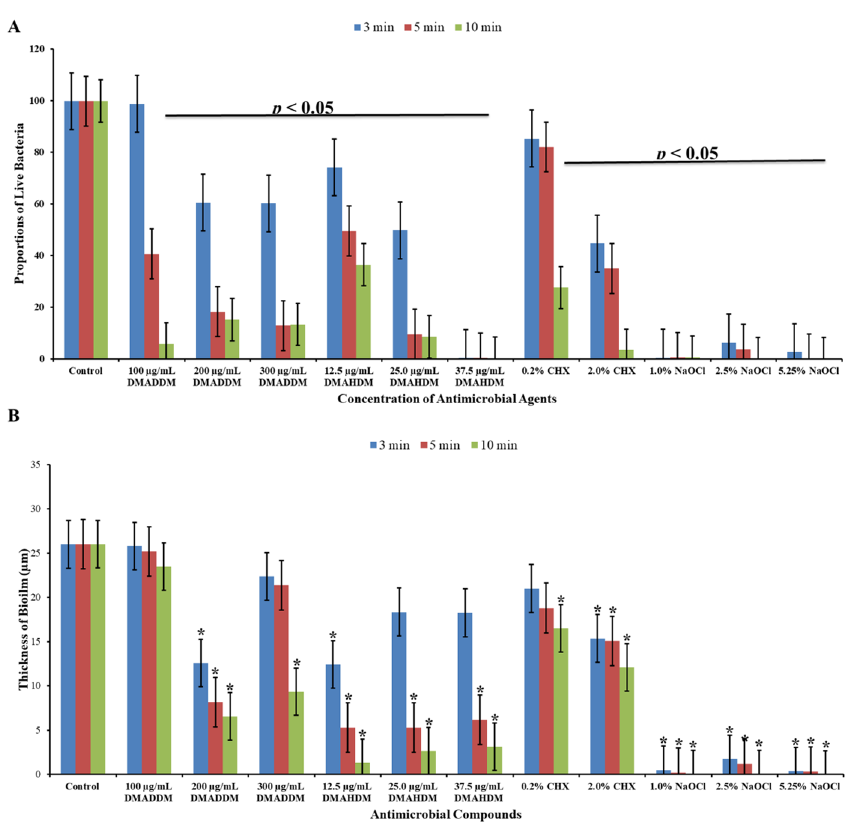
Figure 7. ( A ) Proportion of live bacteria in biofilm after treatment with DMADDM, DMAHDM, CHX and NaOCl for 3 min, 5 min and 10 min. ( B ) Thickness of biofilm after treatment with antimicrobial compounds. Each group name and contact duration is indicated in Image. Higher concentrations of DMADDM and DMAHDM, and increased duration of contact with biofilm provided stronger antimicrobial effect. Data is presented in mean ± standard deviation. * P <